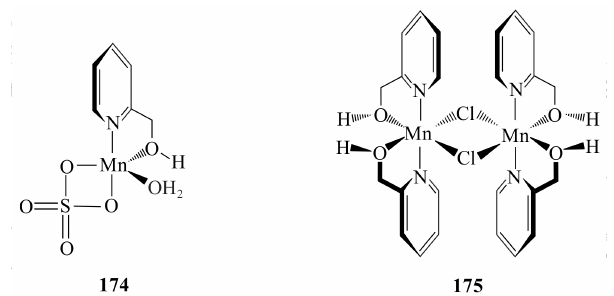
Figure 40. Pyridinyl methanolato complexes of